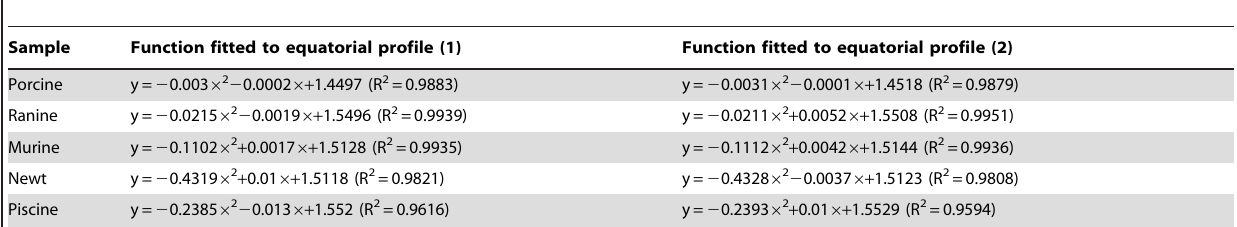
Table 1. Second order polynomial functions fitted to refractive index profiles in the equatorial planes of lenses from five species.